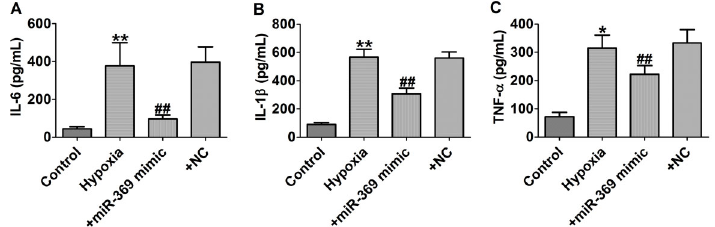
Figure 3. A – C , The concentrations of interleukin (IL)-6, IL-1 b , and tumor necrosis factor (TNF)- a were measured by ELISA assay. Data are reported as means ± SE for n=4. *P o 0.05, **P o 0.01 vs control group; ## P o 0.01 vs hypoxia group (ANOVA). NC: negative control.